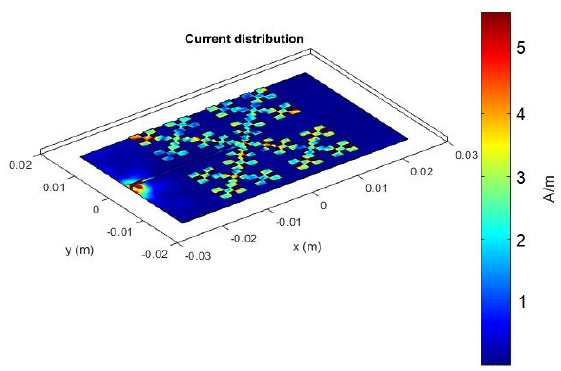
Figure 5. Current distribution of fractal island antenna (normal alimentation).